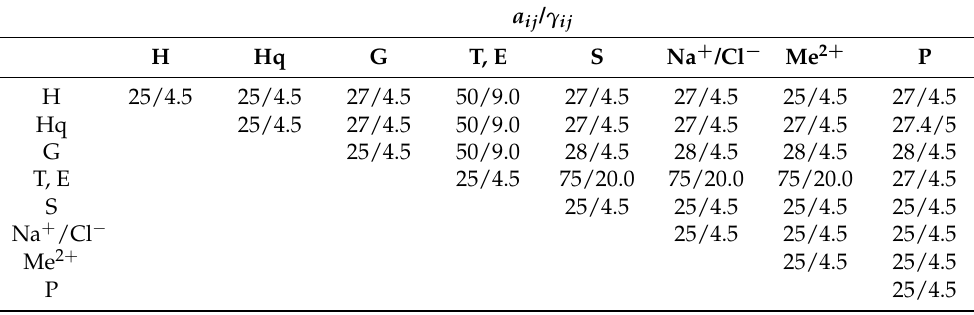
Table 1. Interaction parameters a ij , dissipative coefficients γ ij [53]. H—electroneutral